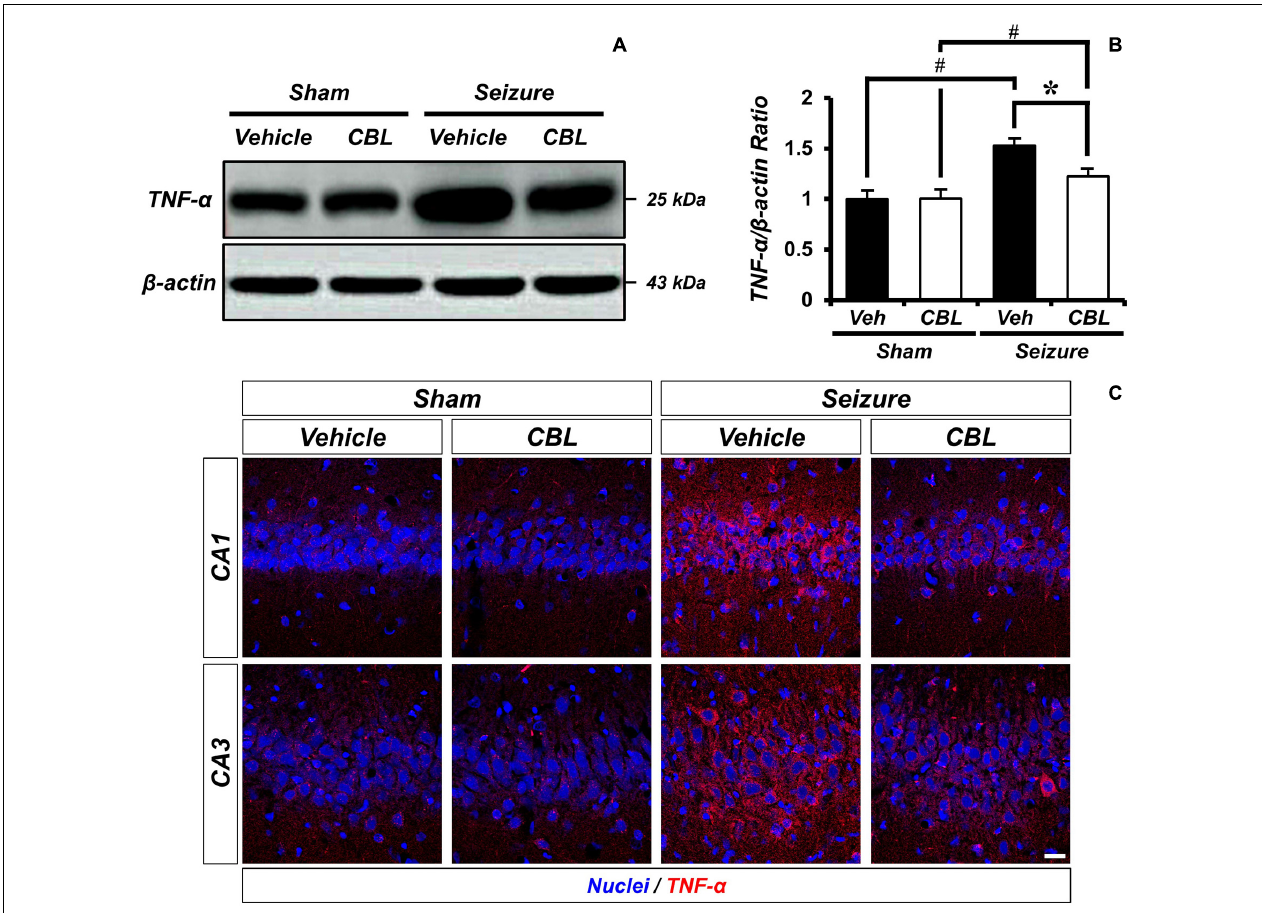
FIGURE 4 | Cerebrolysin decreases level of TNF- α after pilocarpine-induced seizure. The administration of cerebrolysin decreased TNF- α after pilocarpine induced seizure. (A) indicates the level of TNF- α in the hippocampus. After seizure, the administration of cerebrolysin decreased TNF- α expression in the hippocampus compared to vehicle groups. (B) A graph of the TNF- α . (C) TNF- α (red) and DAPI (blue) in the hippocampal CA1 and CA3 regions. The data are mean ± SEM, n = 3–4 from each seizure group. * p < 0.05 vs. vehicle-treated group; # p < 0.05 vs. sham-operated group (Kruskal–Wallis test with post hoc test: Chi square = 17.153, df = 3, p =